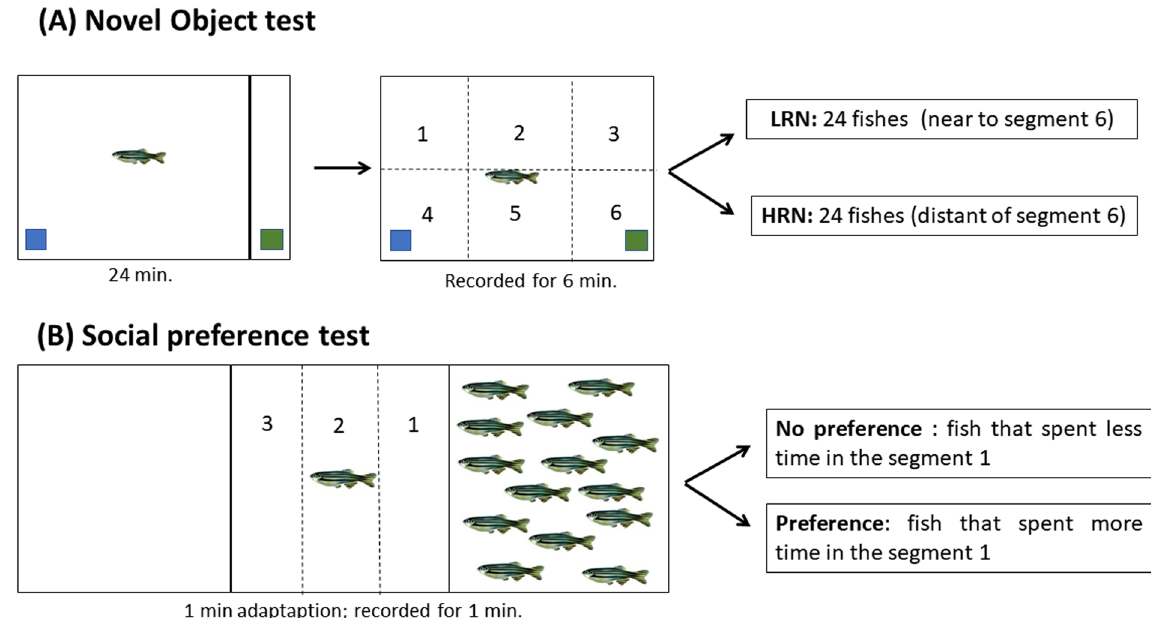
Figure 3. Schematic representation of the methodology used to discriminate exploratory ( A ) and social ( B ) behavior of zebrafish. The drawings in the panels A and B were drawn by